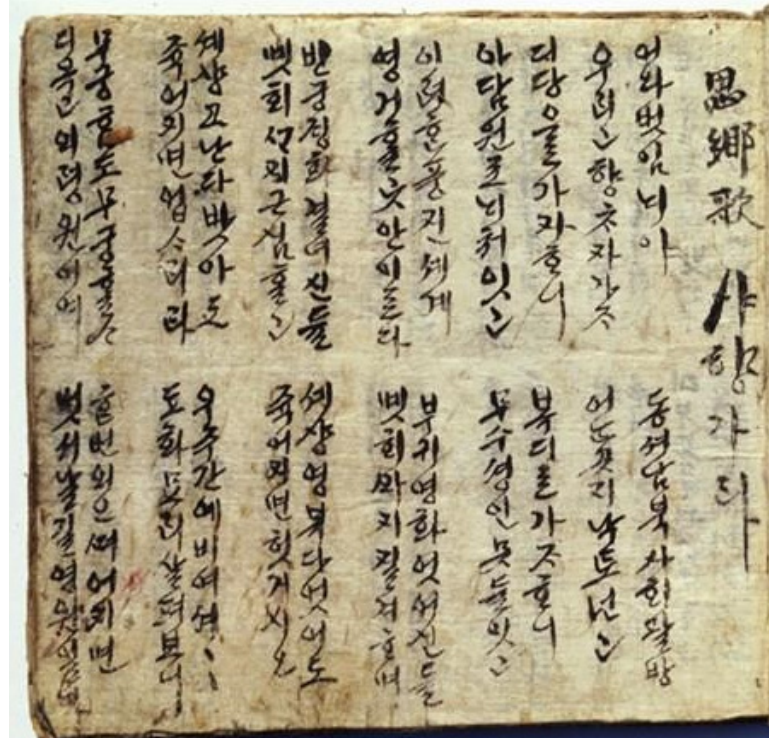
Figure 2. Religious lyric “Sahyangga” (The Academy of Korean Studies 2021).